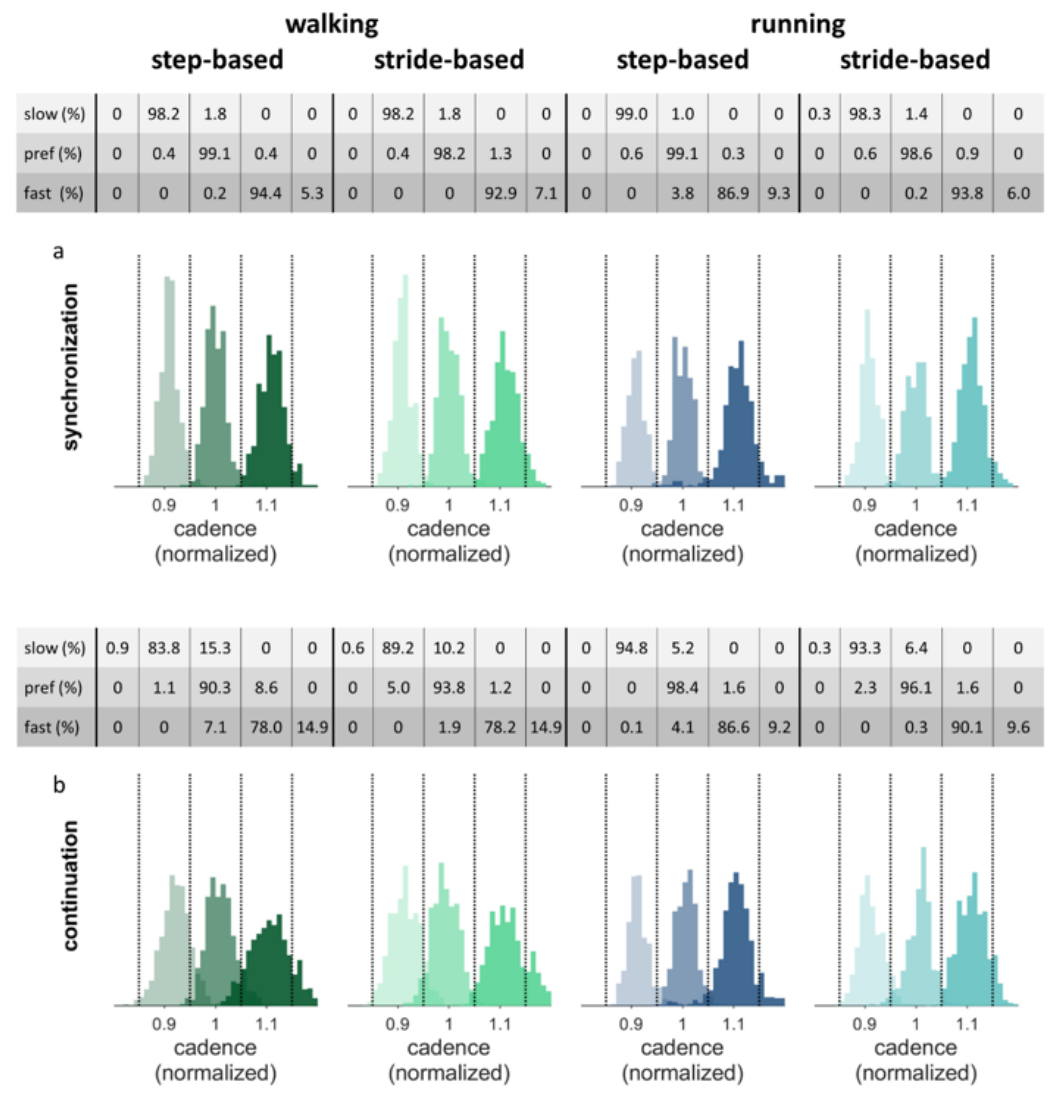
Figure 8. Histograms of the normalized cadence. ( a ) Synchronization phase. ( b ) Continuation phase. Vertical dotted lines represent the borders of the ranges around the slow (0.9), preferred (1.0) and fast (1.1) frequencies. The percentages of cadences falling in each frequency range are displayed above the figure for the three pacing frequencies separately. The data displayed belongs to the nine participants included in the constant error analysis for walking. As some of these participants did not synchronize in all conditions, displayed histograms were based on N = 7 for running with preferred step-based, slow and preferred stride-based pacing conditions and N = 6 for the running with slow step-based pacing conditions.